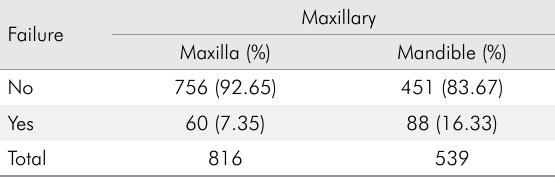
Table 8. MSI failure according to bone location.